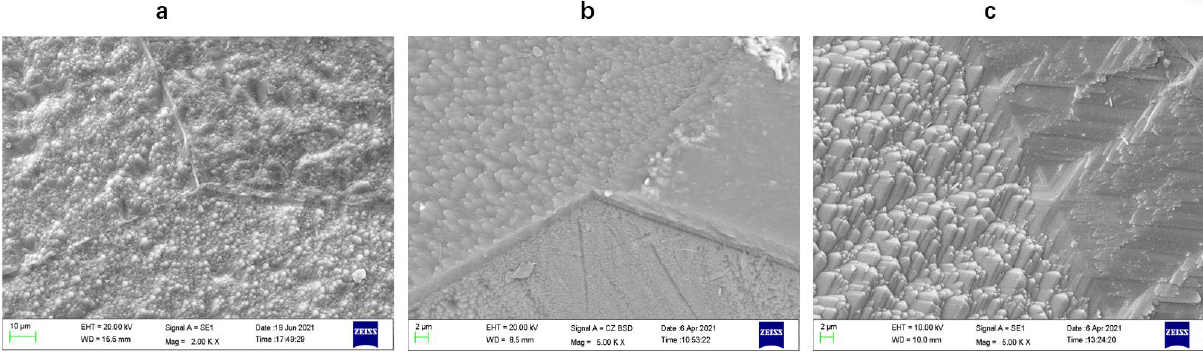
Figure 7. Dislocation distribution of Mc-Si at different heights. (a) Electrophoretic deposited quartz powder, (b) spray quartz powder, and (c) silicon particles.